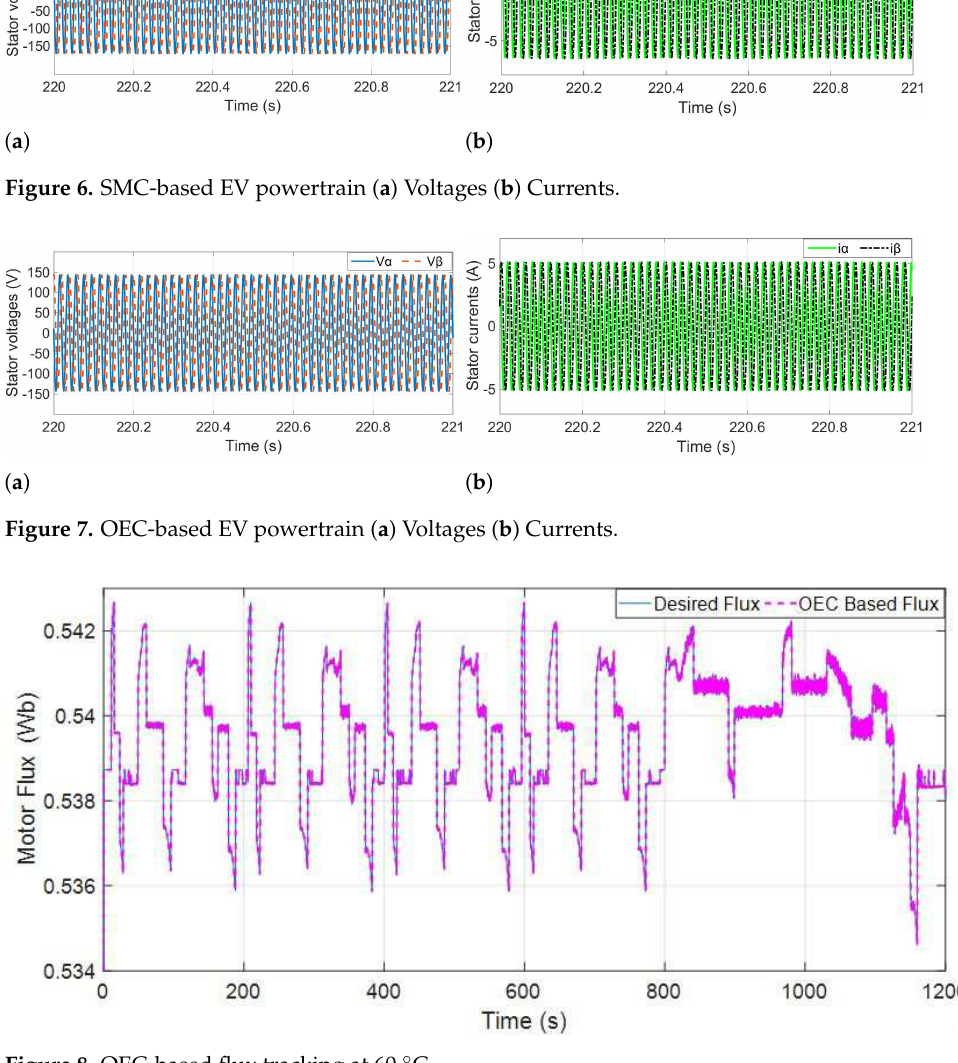
Figure 8. OEC-based flux tracking at 60 ◦